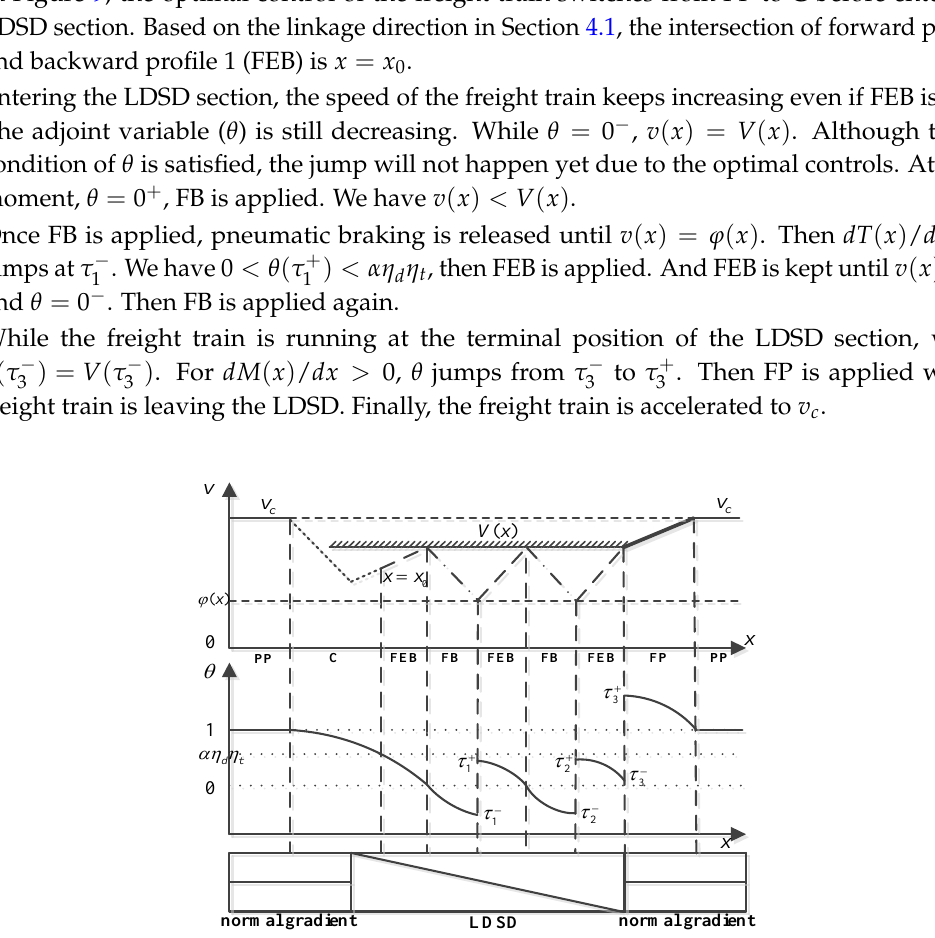
Figure 9. Linkage of the speed holding section considering the LDSD section ( v c > V ( x )